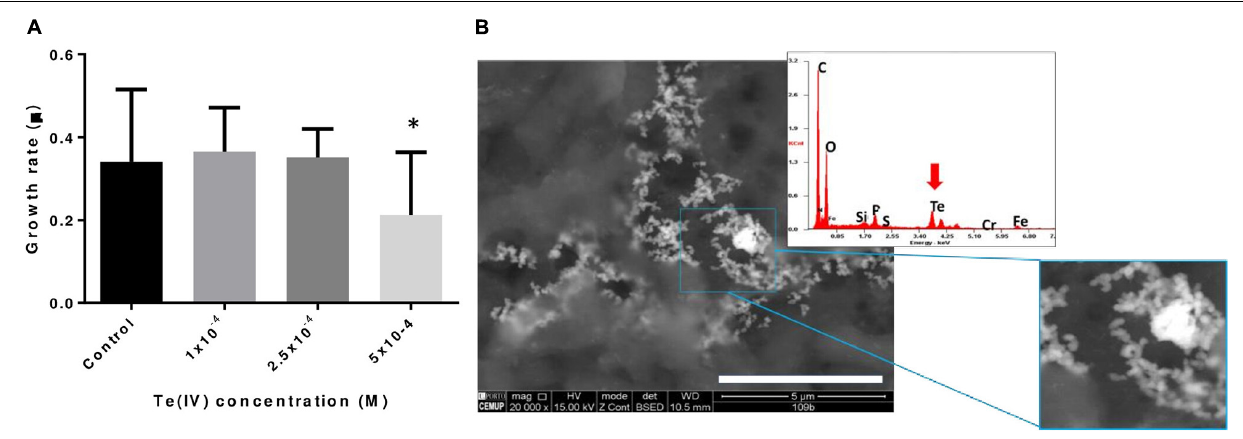
FIGURE 1 | Impact of tellurite in bacterial growth and tellurite reduction. (A) Specific growth rates of Paenibacillus pabuli ALJ109b at increasing concentrations of Te (IV): control without metal, 1 × 10 − 4 M Te (IV), 2.5 × 10 − 4 M, and 5 × 10 − 4 M. Experiments were conducted in triplicate, and statistical significance indicated ∗ p ≤ 0.05. (B) SEM micrographs of Te nanostructures produced with P. pabuli ALJ109b cells grown in the presence of 5 × 10 − 4 M Te (IV). A magnification is present for clarification of the nanostructure shape. High-density metal deposits are represented in white. The EDS spectrum was obtained from reads in an electrodense area. The red arrow highlights Te detection in the spectrum.